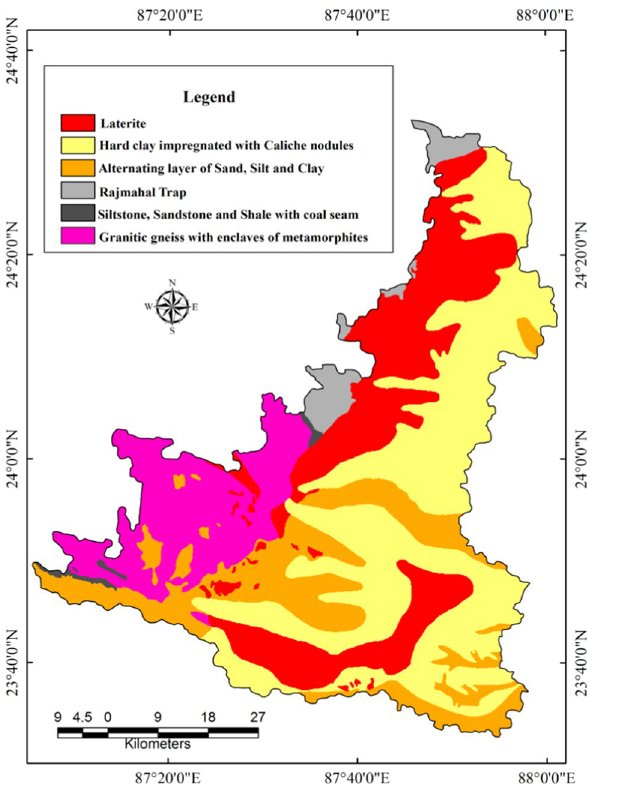
Fig. 2 Geological facies of Birbhum District Fig. 3